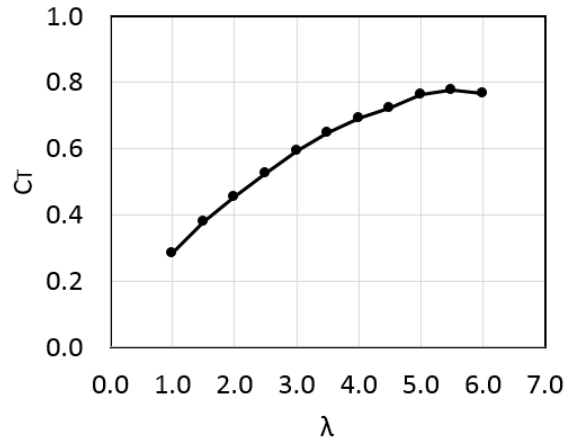
Figure 8. Wind turbine thrust coefficient over a flat terrain.